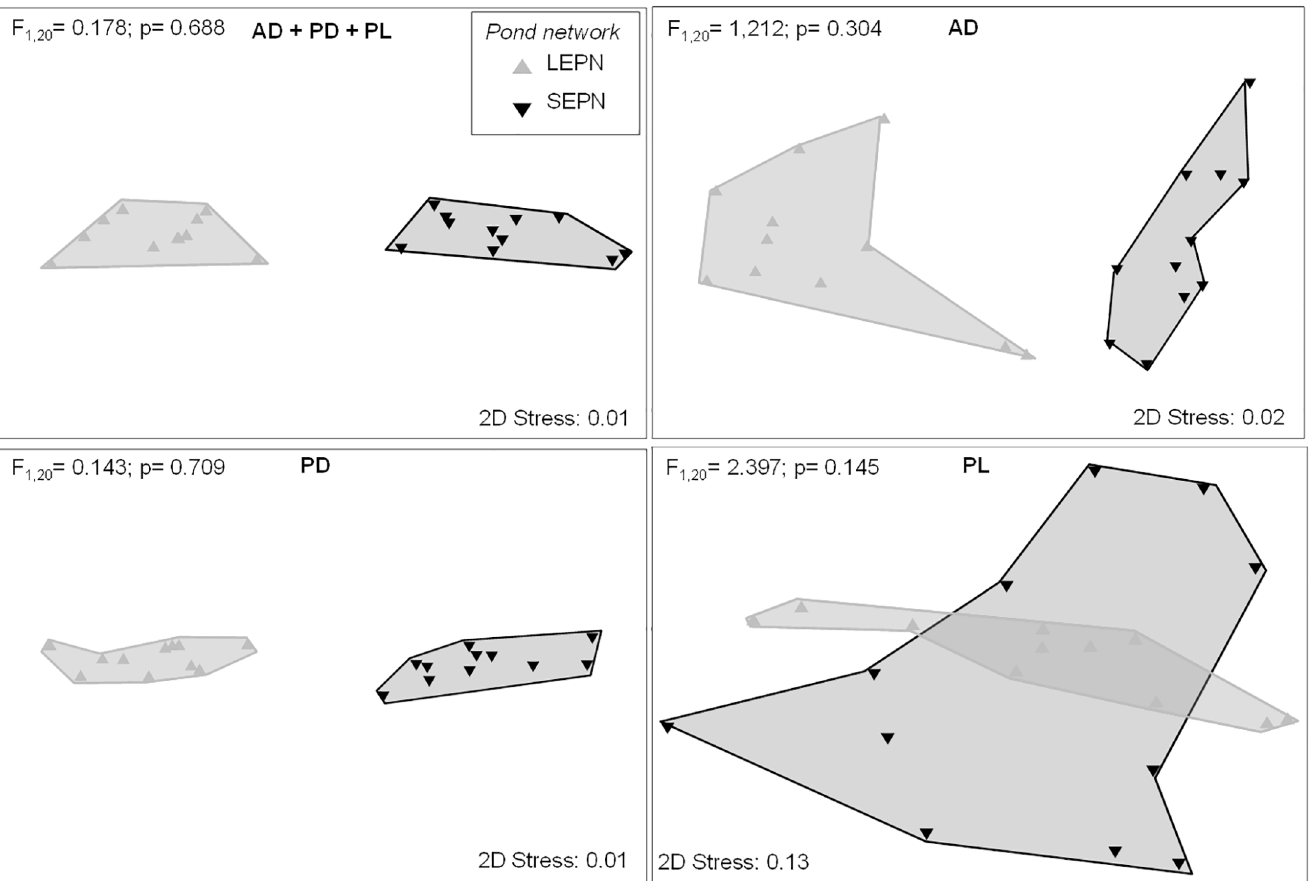
Fig 2. Non-metric multidimensional scaling (NMDS) ordinations of the ponds considering the whole environmental matrix (Euclidean distances) and the three biotic groups (top, left); considering only the environmental variables with the highest correlation for AD (top, right), PD (bottom, left) and PL (bottom, right) (see Table 2). PERMDISP results are shown.